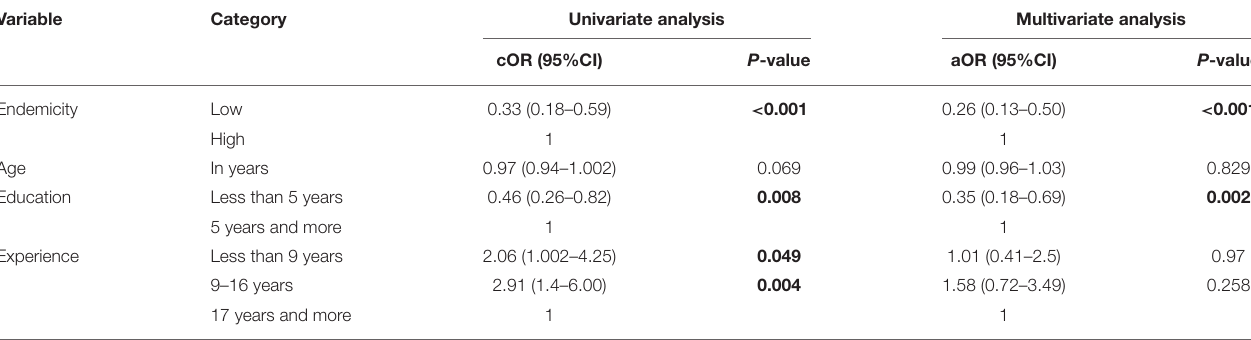
TABLE 2 | Factors affecting mitanin’s performance using ordinal logistic regression ( n = 203). Variable Category Univariate analysis Multivariate analysis cOR